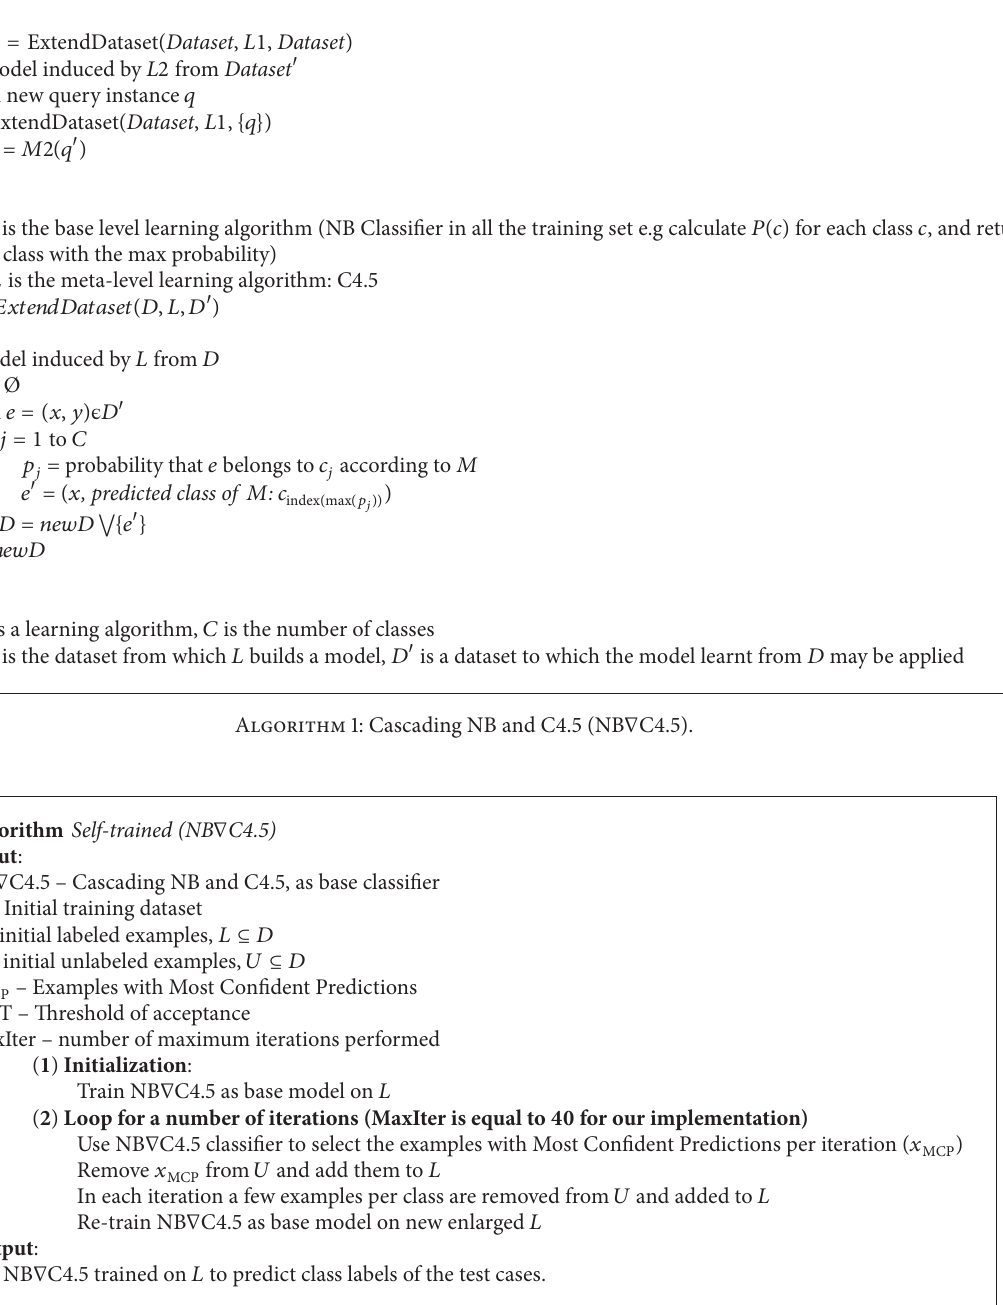
Algorithm CascadeGeneralization(L1, L2, Dataset)